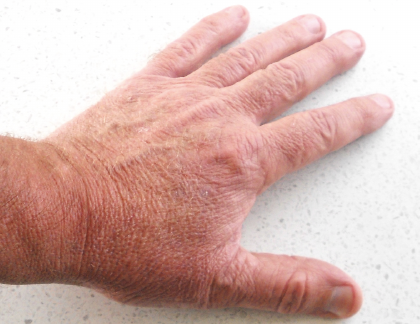
Figure 3: Hand at two years after treatment, showing normal skin and no signs of